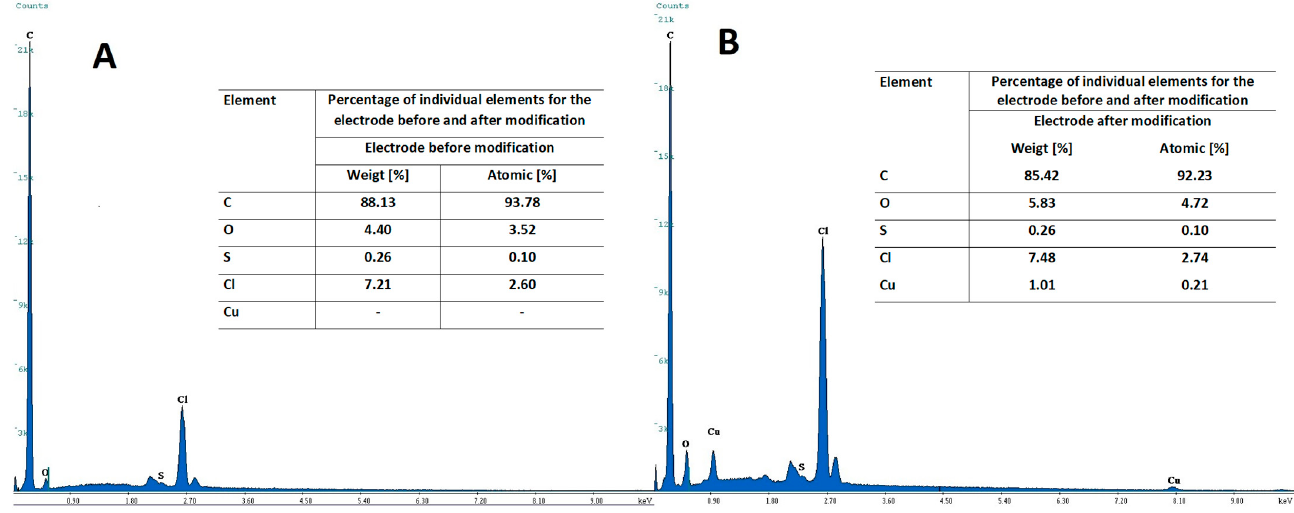
Figure 9. EDX spectra obtained for electrode non modified ( A ) and modified with copper ( B ) from the solution containing 0.1 M HCl and 2 × 10 –4 M Cu(II).